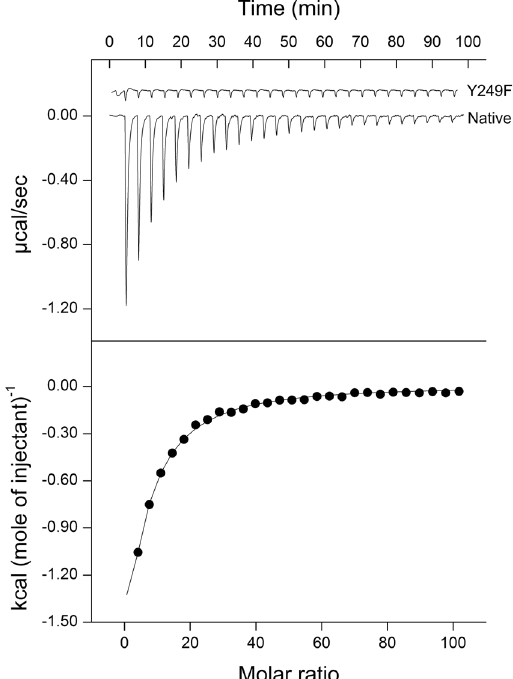
Figure 5. ITC titrations of TlpC LBD and its Y249F variant with lactate. The upper panel shows raw titration data, where each peak corresponds to the injection of 10 μ l of 5 mM sodium L- lactate into a 1.45-ml reaction cell containing 10 μ M protein. The lower panel shows the integrated and dilution-corrected peak areas of the titration